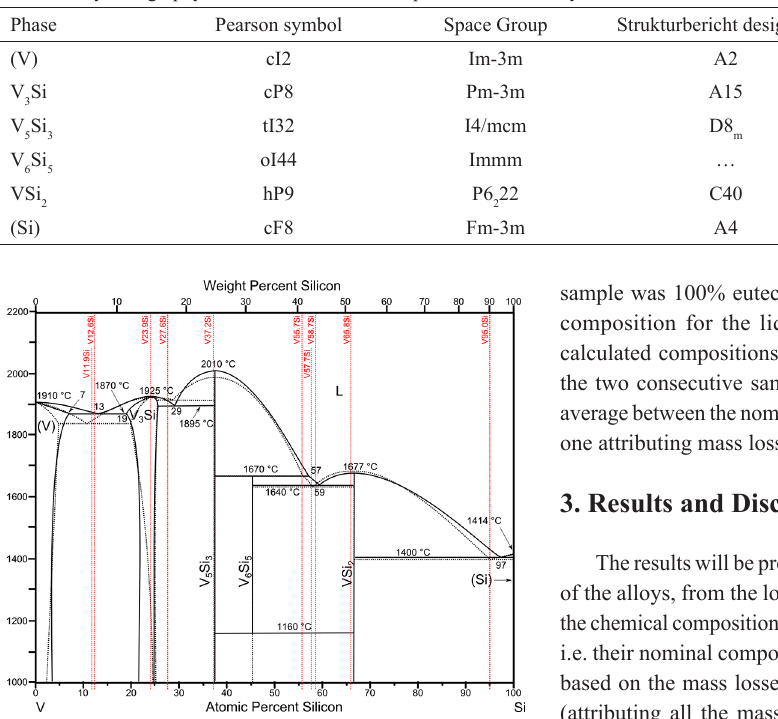
Figure 1: V-Si Phase Diagram proposed by Smith 2 (solid lines) and Zhang et al. 5 (dashed lines). Vertical lines indicate the assumed compositions of the alloys prepared in this